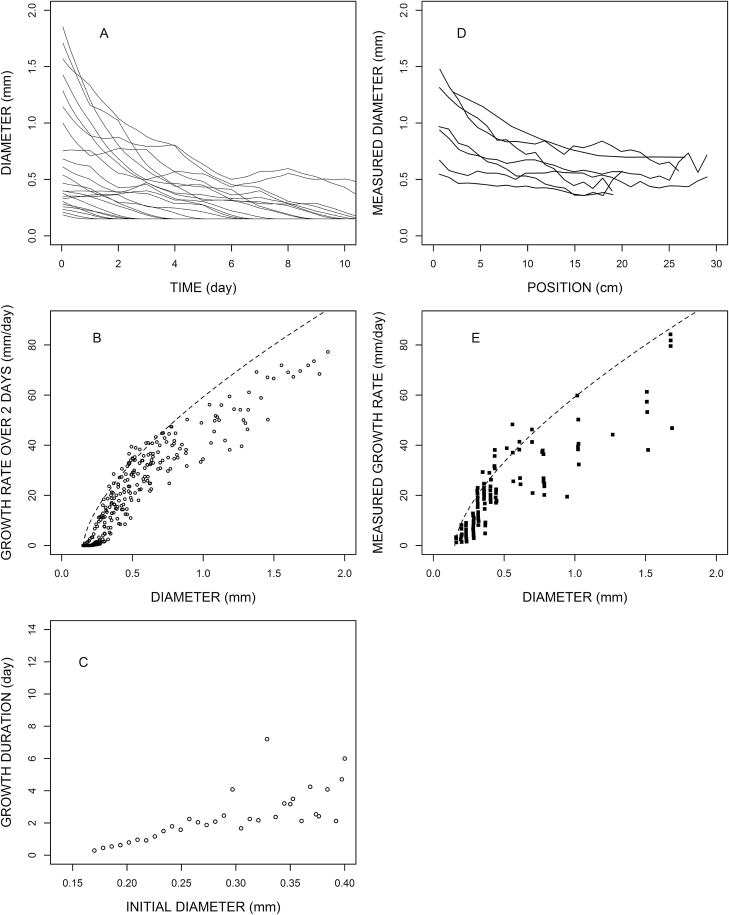
Simulation of emergent properties (A, B, C) and comparison with experimental data obtained on maize. (D) is redrawn from Wu et al. (2016) and (E) is redrawn from Cahn et al. (1989). Root parameters are: dmin=0.15 mm, dmax=2.0 mm, e= –0.35, K=10 μm h–1, kel=0.8 mm h–1).